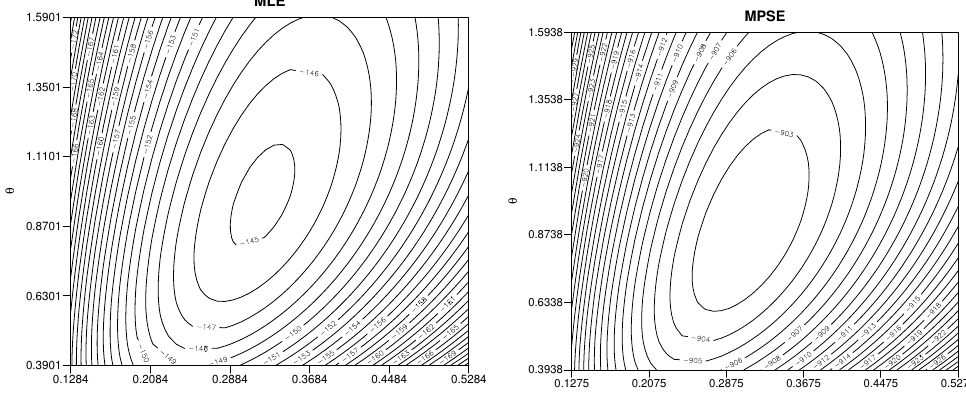
Figure 4. Contour plots of θ and α using the likelihood function ( left ) and MPE function ( right ) based on data set (i).